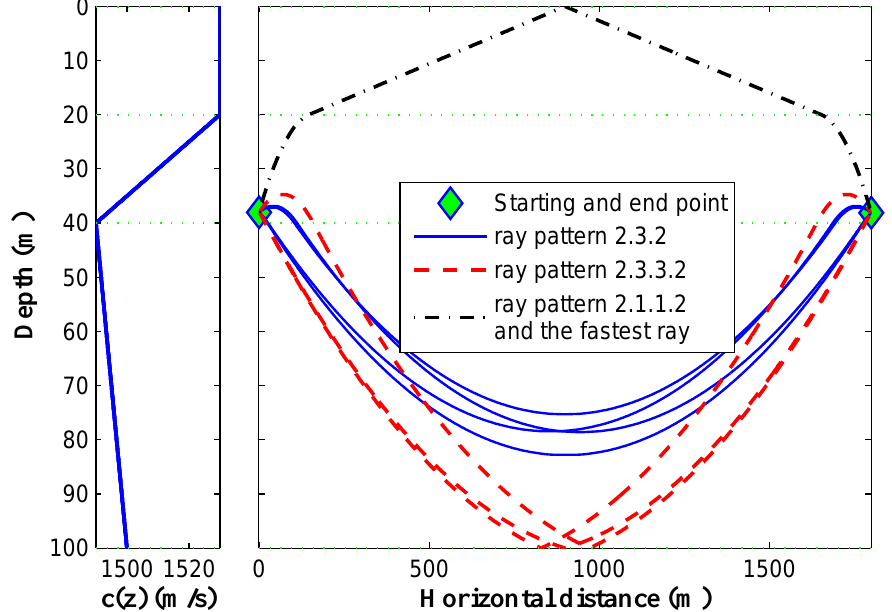
Figure 9. Different possible rays between two points in the second